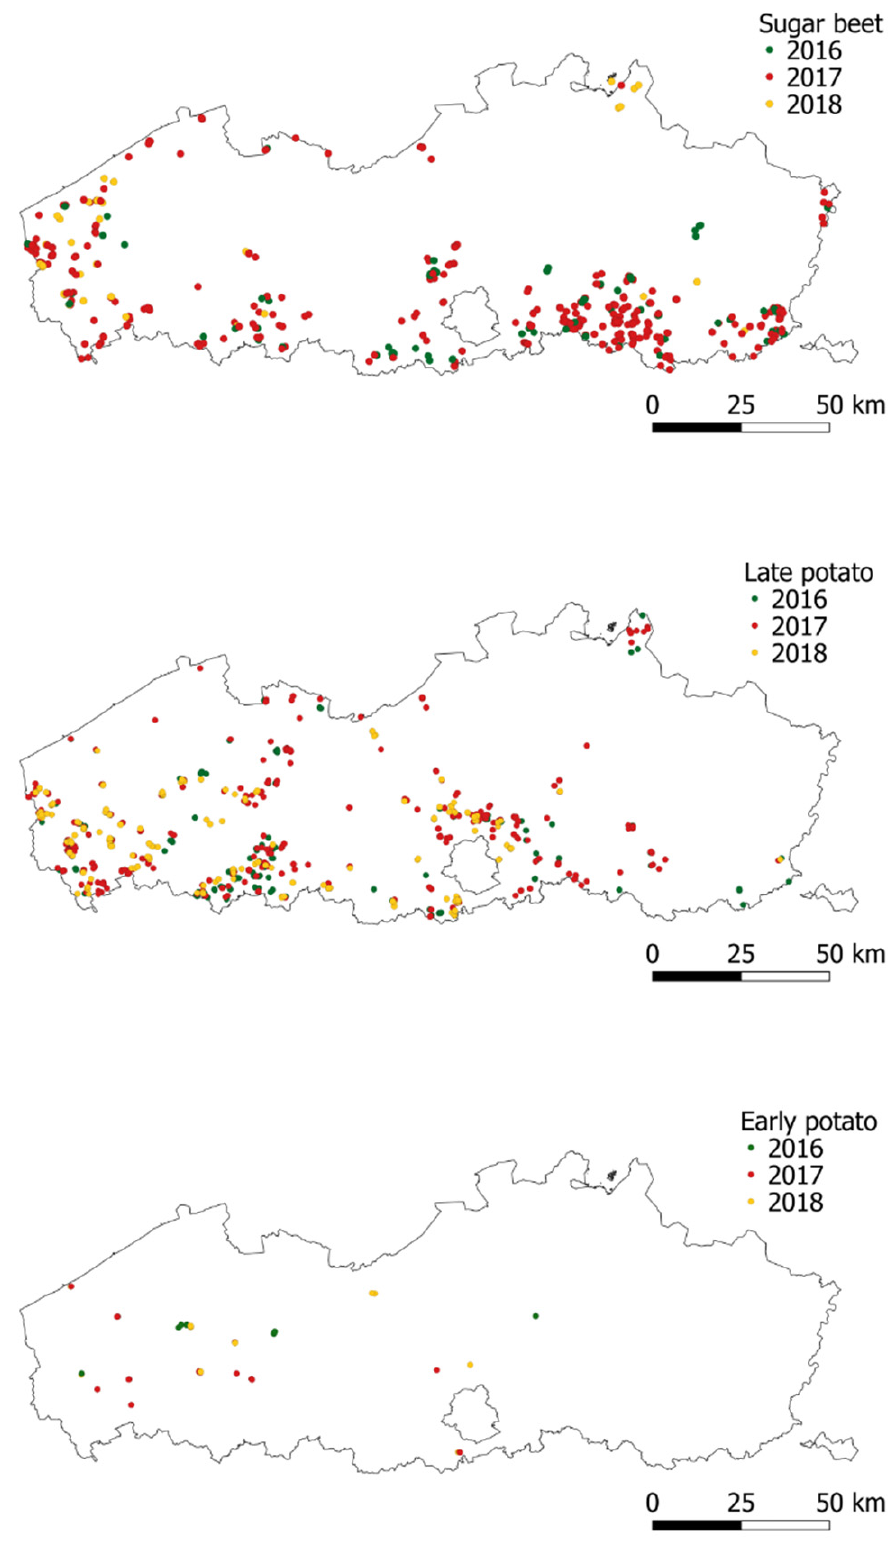
Figure 1. Locations of sugar beet (468 fields), late potato (685 fields), and early potato (38 fields) for the years 2016, 2017, and 2018 in northern Belgium.